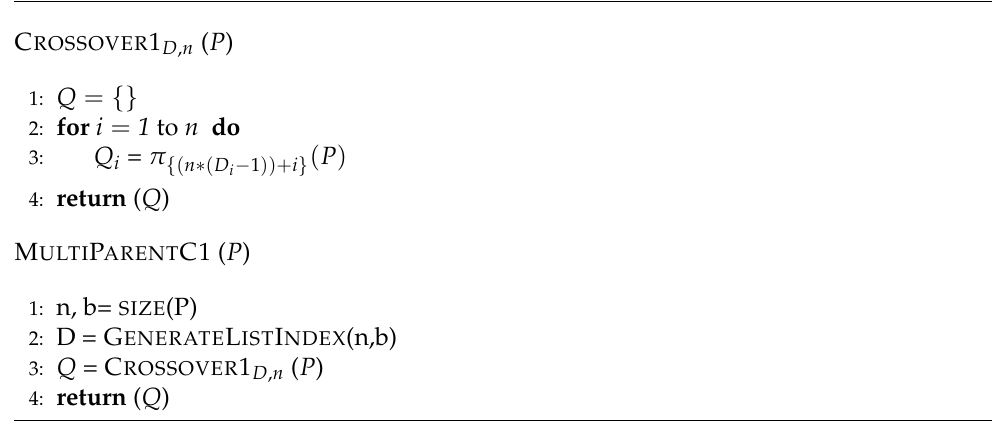
Algorithm 4 MultiParent Crossover-M ULTI P ARENT C1